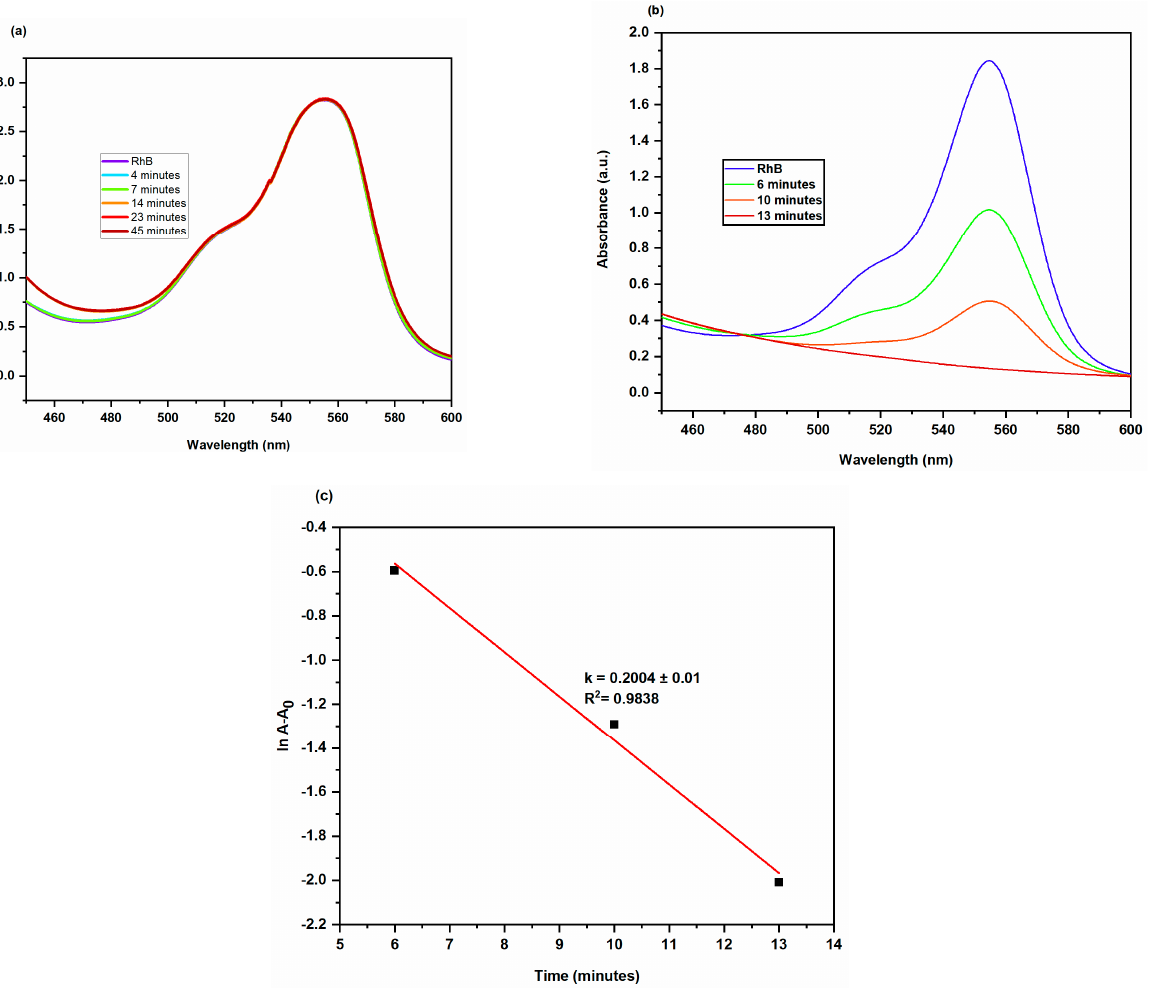
Figure 14. At 25 °C, successive UV-Vis absorbance spectra showing reduction of RhB by NaBH 4 ( a ) reaction mixture without AgNPs ( b ) reaction mixture containing 0.2 mL of AgNPs ( c ) Smooth plots of ln A/A 0 versus time for the degradation of RhB at 25 °C.